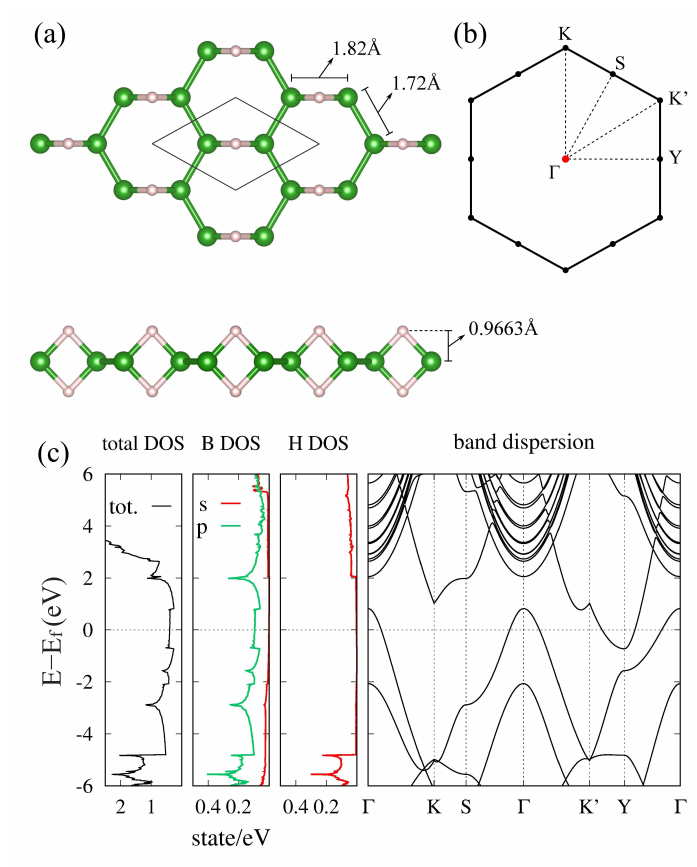
Figure 3. ( a ) Lattice structure and ( b ) BZ of the hexagonal HB. ( c ) Density of states and electronic band dispersion of the hexagonal HB (adapted from